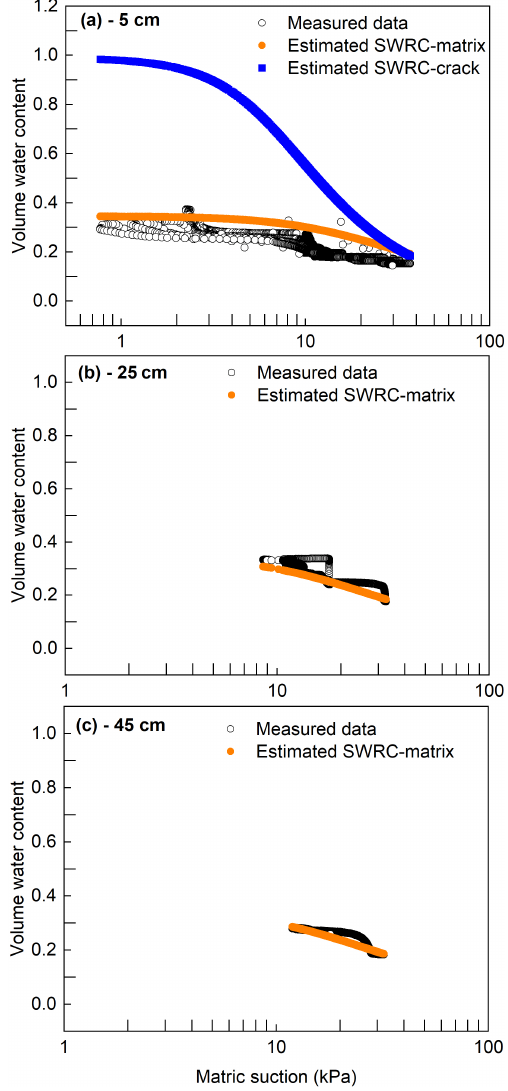
Figure 11. Measured and estimated SWRC at different depths: (a) 5cm, (b) 25cm and (c)